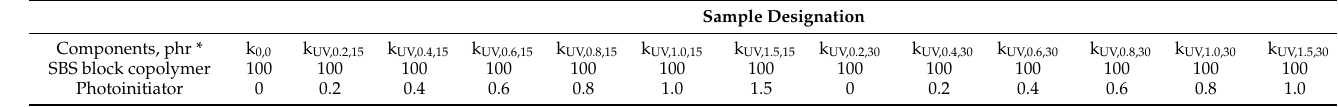
Table 1. Batch compositions in phr